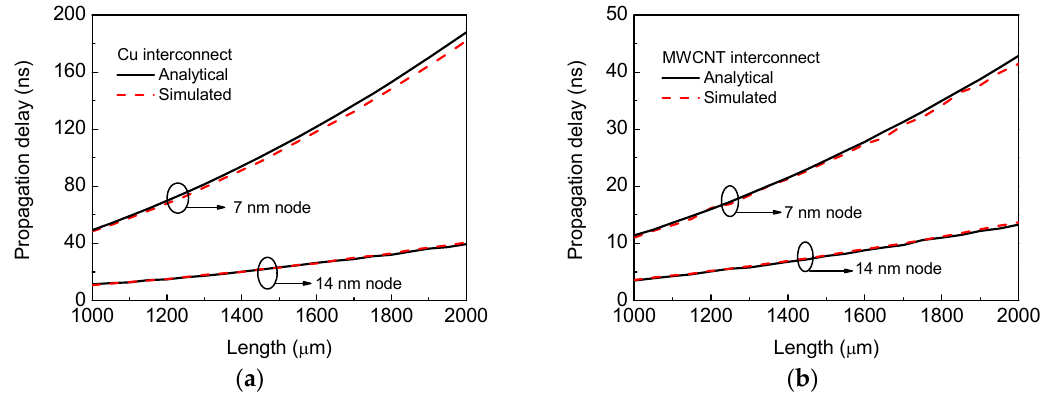
Figure 4. Distributed circuit model of a driver ‐ interconnect ‐ load (DIL) system. Appl. Sci. 2018 , 8 , x FOR PEER REVIEW